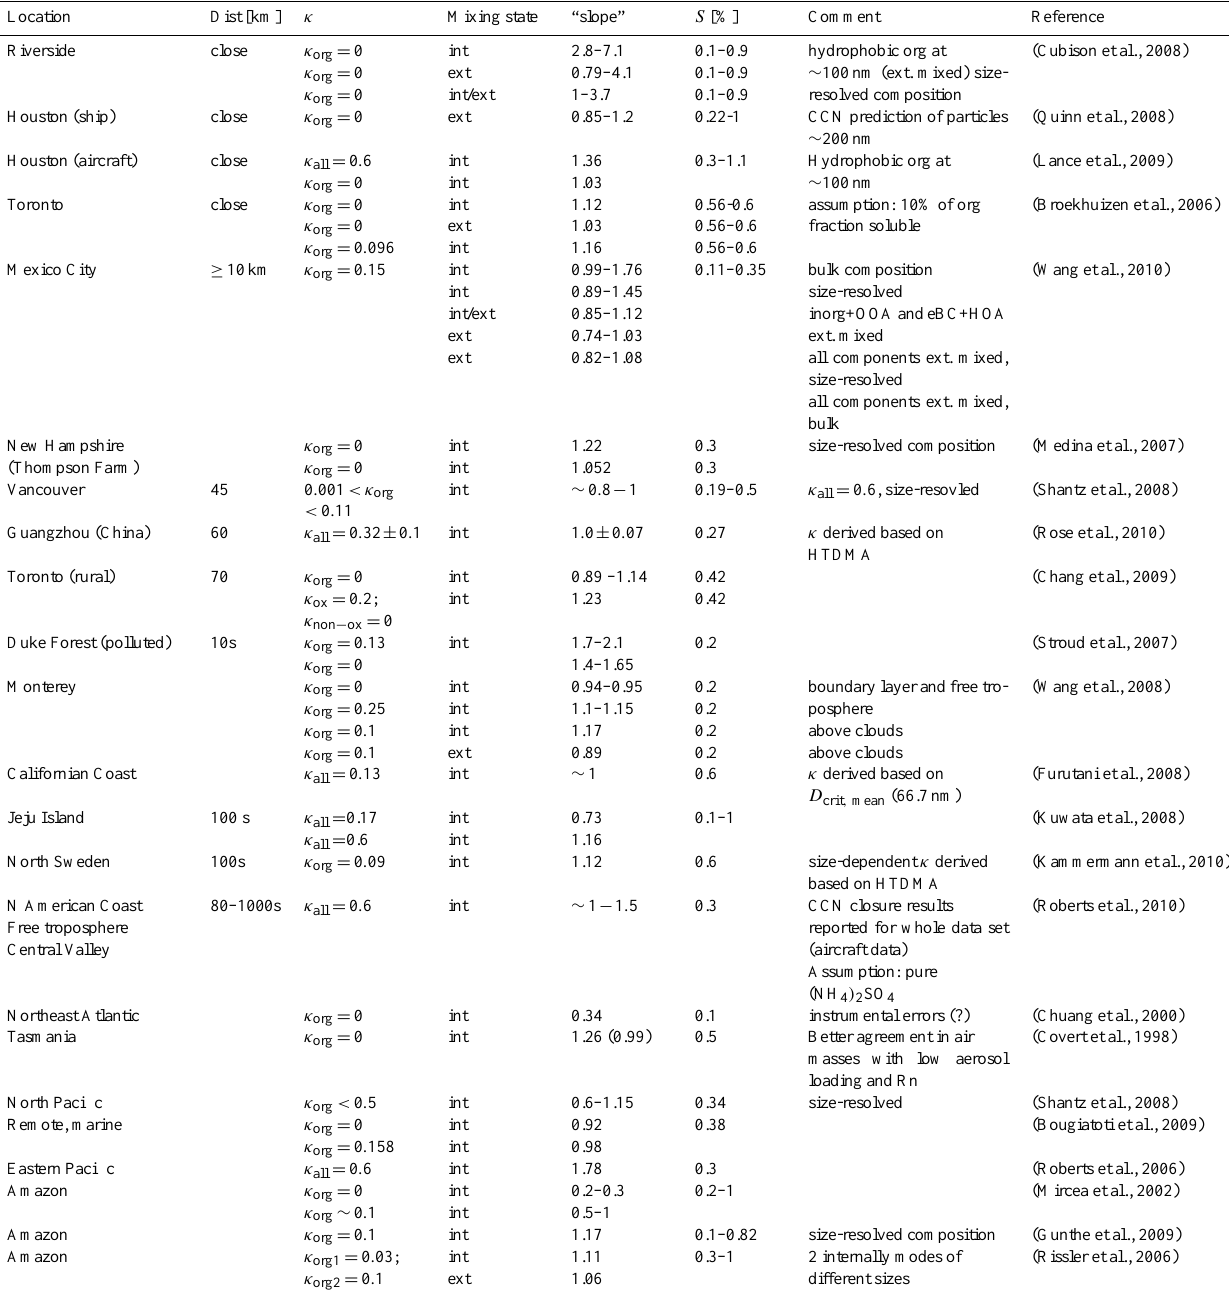
Table 3. Summary of previous CCN closure studies. “Dist” is the approximate distance from major emission sources, κ org is the hygroscop- icity parameter of the organic fraction, κ all is the hygroscopicity parameter of the total aerosol (if κ was not provided in the original literature it was derived here based on reported composition/hygroscopicity data); “slope” is the ratio of CCN (calculated)/CCN (measured), and S is the supersaturation (range). If not otherwise noted, all studies assume bulk